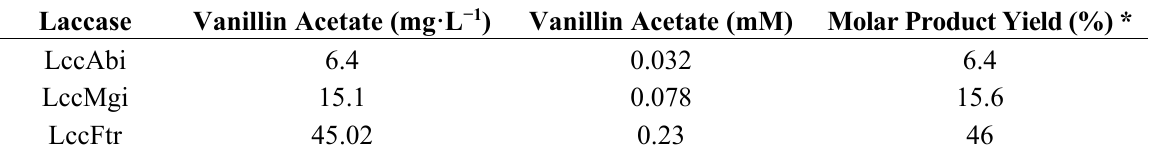
Table 2. Yield of vanillin acetate after cleavage of monoacetyl curcumin in a biphasic